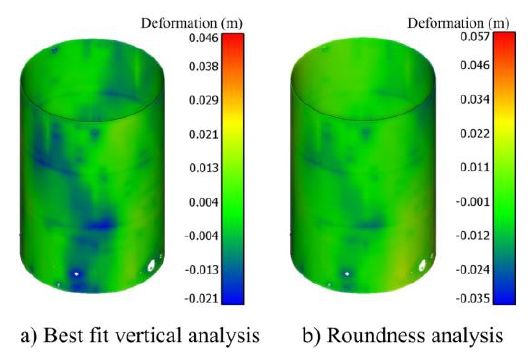
Figure 4 . Deformation of a shell